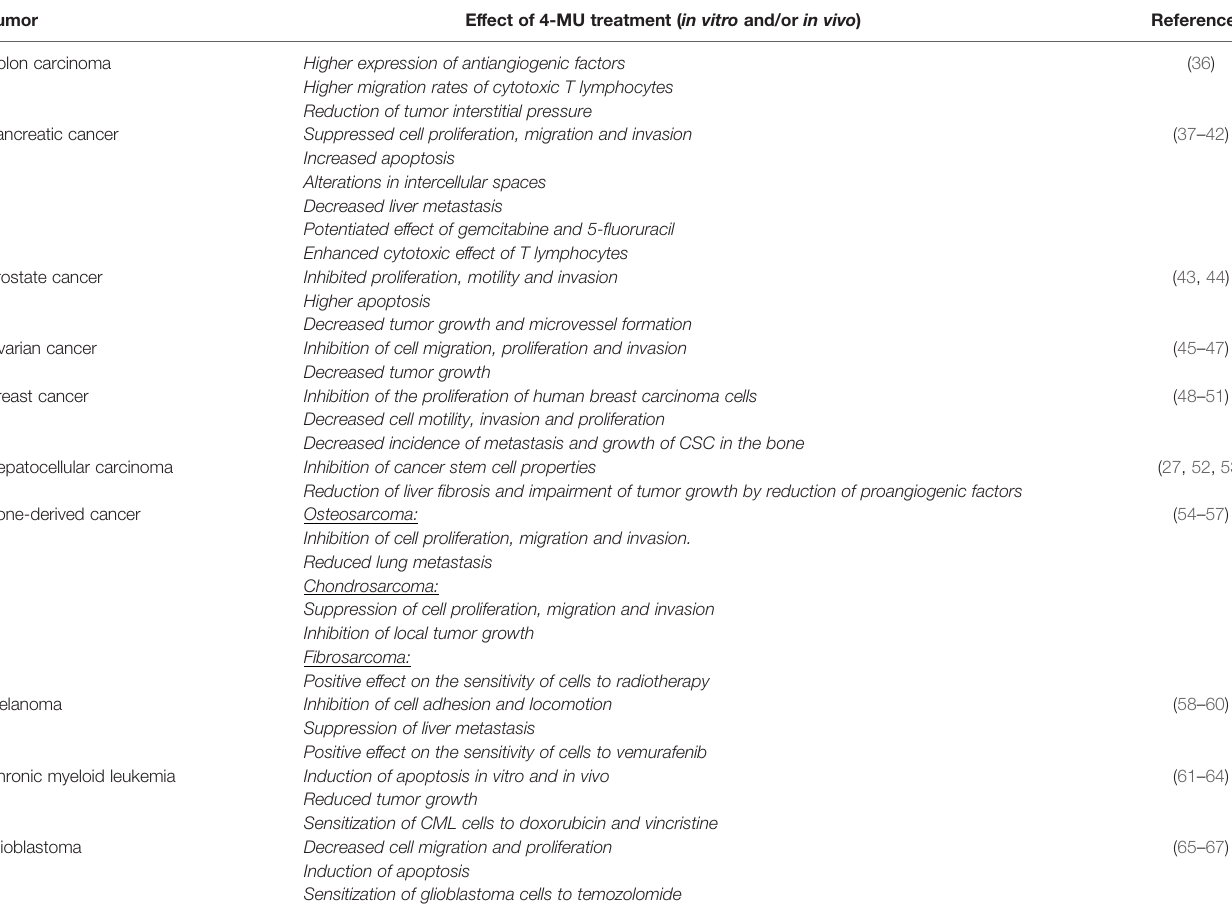
TABLE 1 | Effect of 4-MU treatment in different types of tumors.